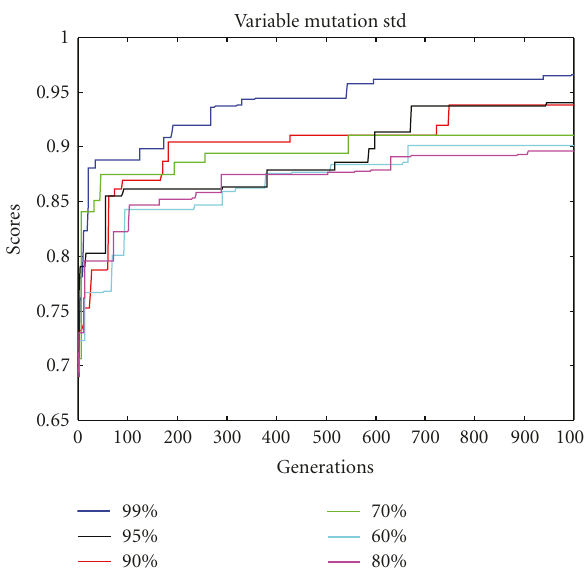
Figure 7: Fitness in various mutation